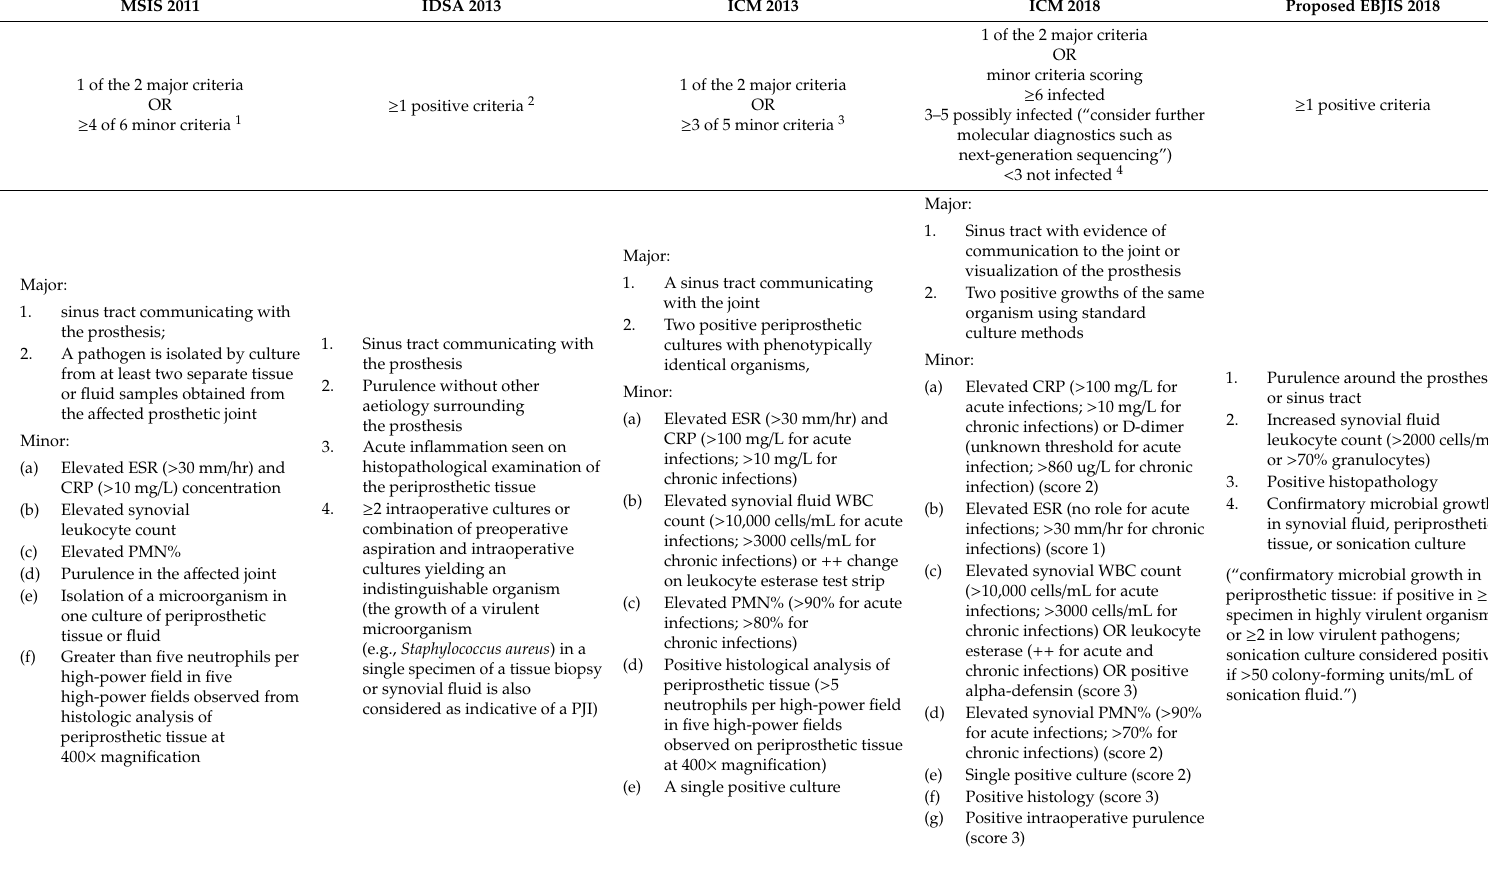
Table 1. Comparison of the diagnostic criteria adopted by five peri-prosthetic joint infection (PJI) definitions, published from 2011 to 2018 (modified from [13]). MSIS: Musculo-Skeletal Infection Society; IDSA: Infectious Disease Society of America; ICM: International Consensus Meeting; EBJIS: European Bone and Joint Infection Society.